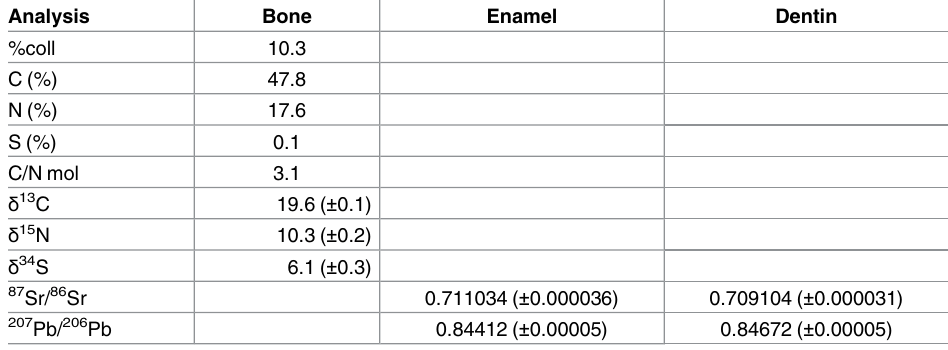
Table 3. Data of the isotope analysis from femur bone collagen (C, N, S), tooth enamel and dentin samples (Sr, Pb), mean and standard